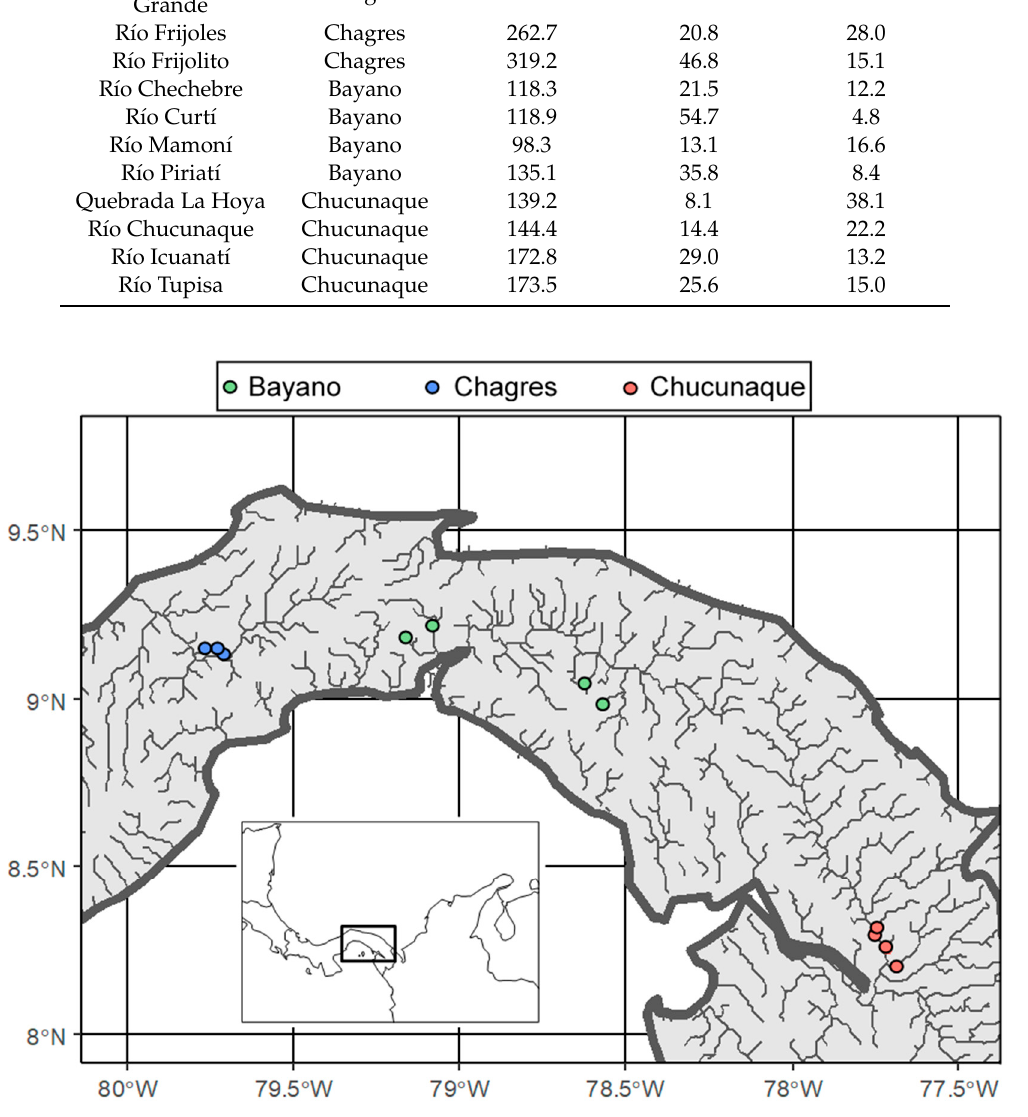
Figure 1. Map of study sites in eastern Panama. Sites are color-coded by the major basin in which they occur. Inset map shows the location of the study sites relative to Panama and surrounding countries.